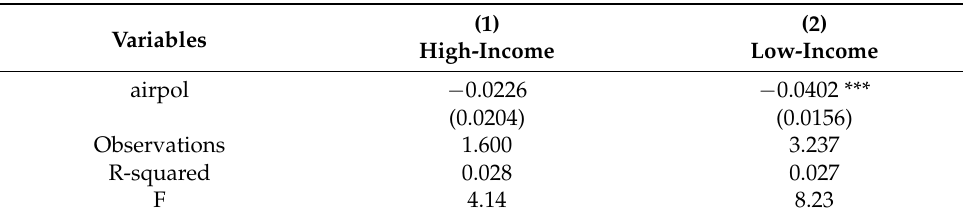
Figure 2. Effect of air pollution on well-being. Table 3. Income heterogeneity.